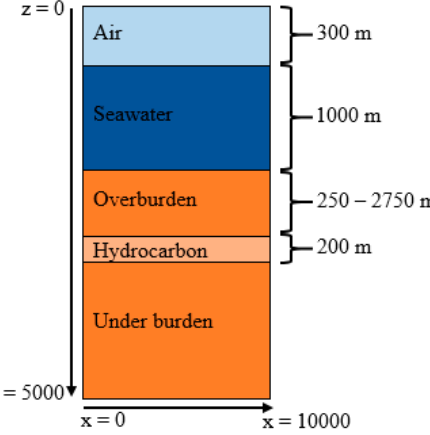
Figure 2. Illustration of SBL models used in this study. The thicknesses of air, seawater, and hydrocarbon are 300, 1000, and 200 m, respectively. The depth of the hydrocarbon layer (thickness of overburden layer) is varied from 250 m to 2750 m with an increment of 250 m. The total height and length of the models are 5000 and 10,000 m, respectively.